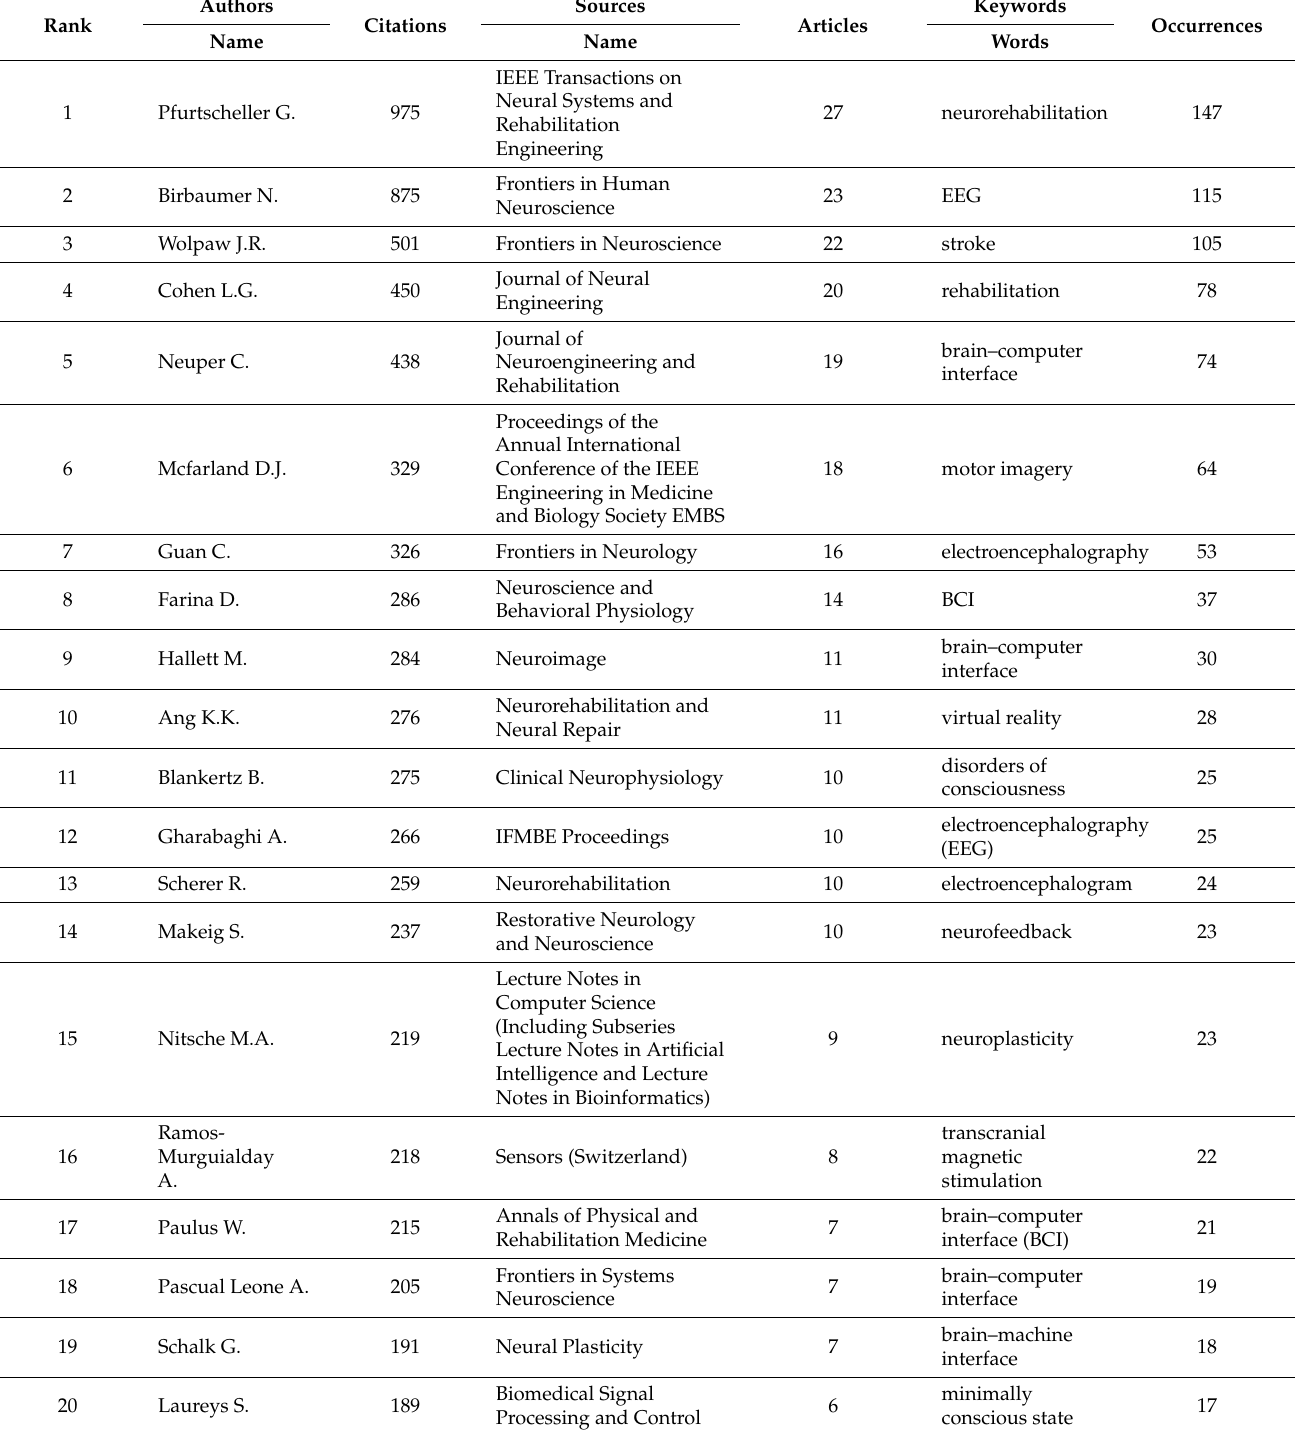
Table 4. Top-20 most-cited authors, sources, and